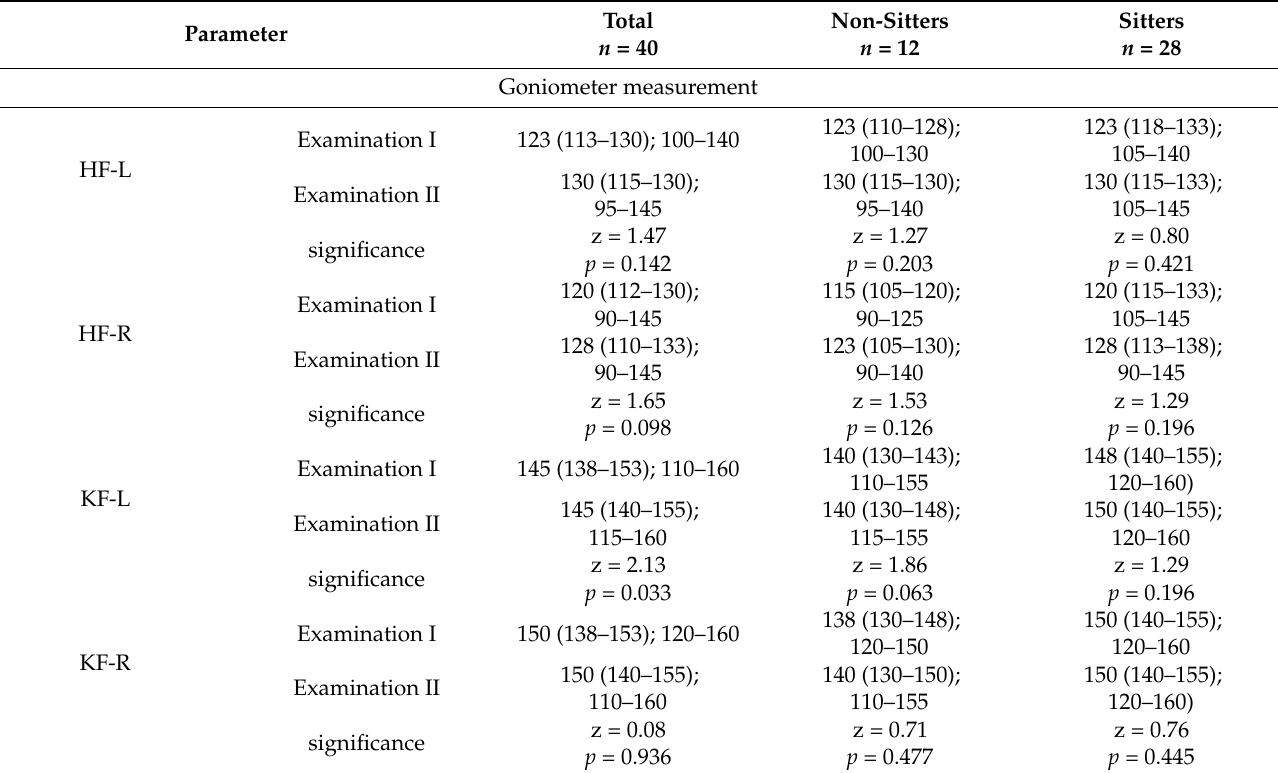
Table 2. Changes in mobility range parameters between the 1st and 2nd examination. Me (Q25–Q75) and min–max values were indicated. Significance of differences was tested using the sign test, with z- and p -values